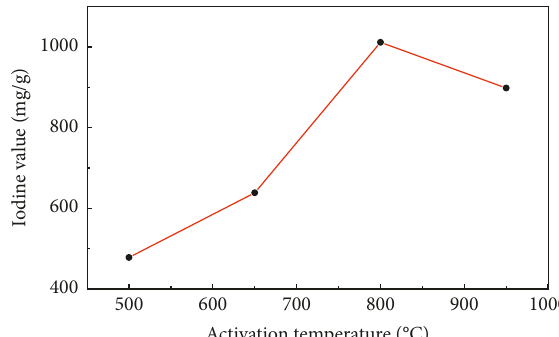
Figure 2: The influence of the activation temperature on the iodine value of sludge carbon.